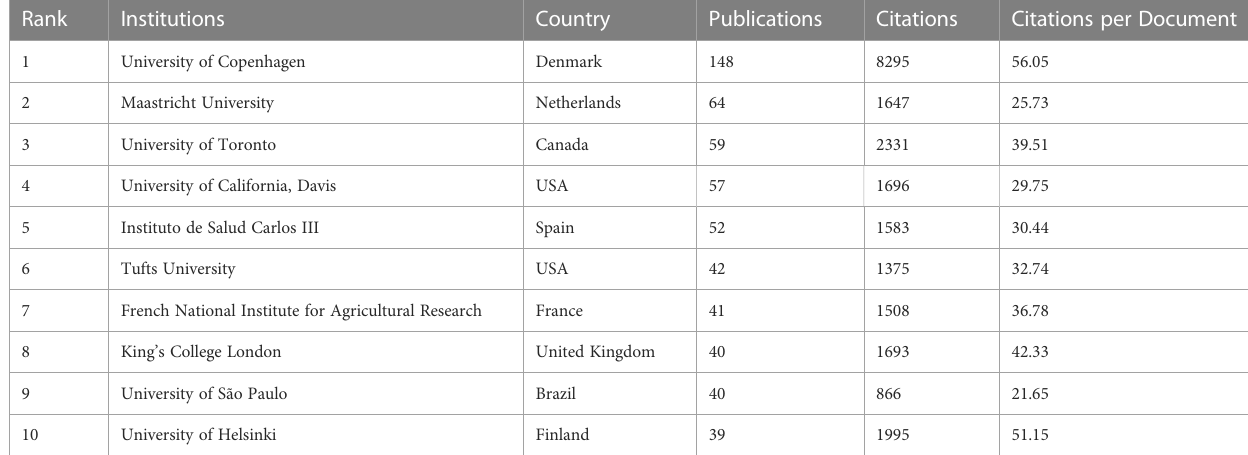
TABLE 1 Top 10 institutions engaged in research on non-fasting lipid.